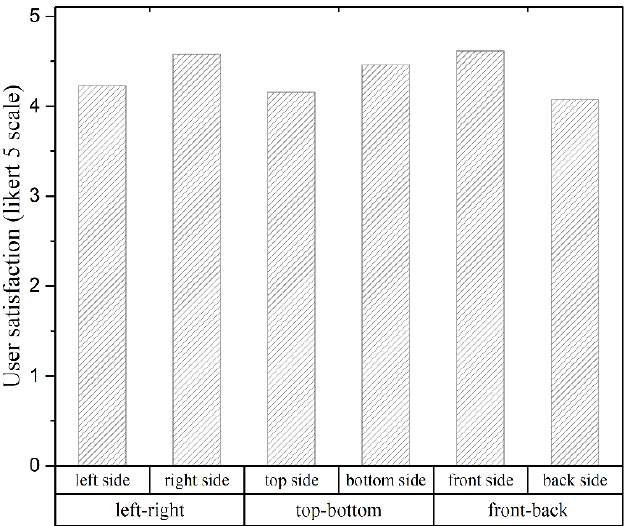
Figure 11. Average user satisfaction obtained from six types of positions (virtual object-generation positions).